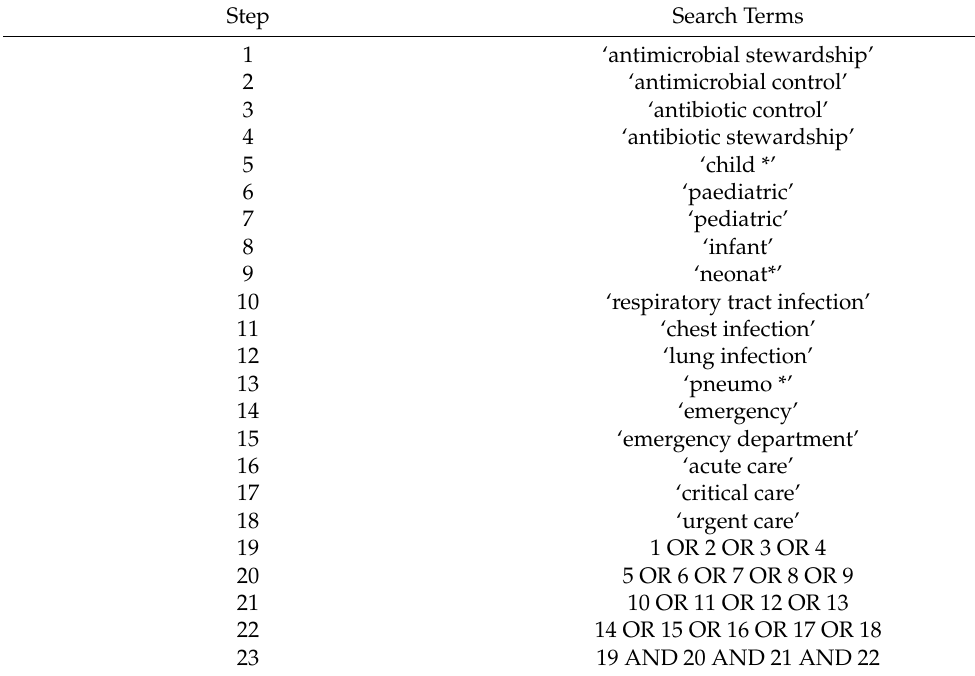
Table A1. Search Strategy Used for PubMed, MEDLINE, Embase and Cochrane Database of System- atic Reviews.